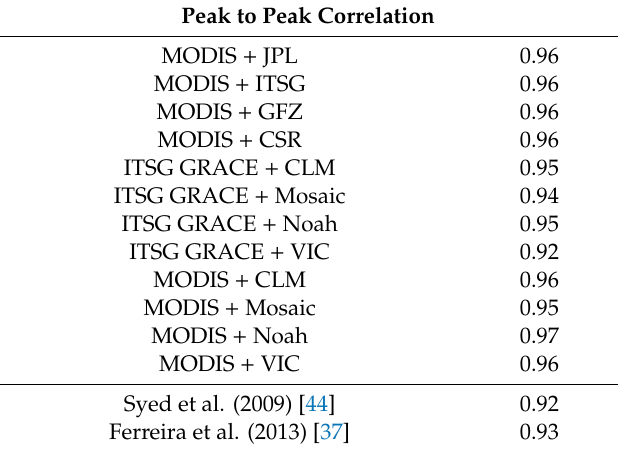
Table 7. Peak-to-peak correlation between the remotely sensed runo ff and the ground-based observed runo ff . Peak to Peak Correlation MODIS +